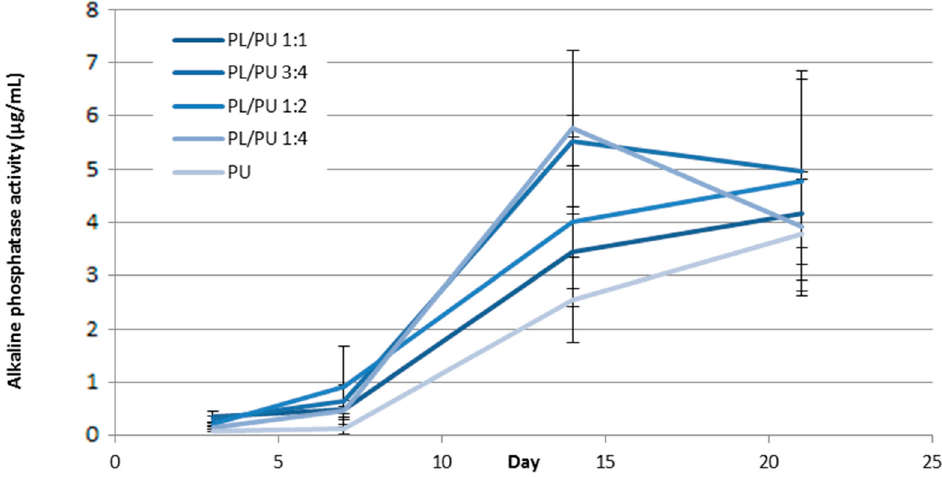
Figure 6. Alkaline phosphatase activity throughout a 21-day culture period expressed in 7F2 cells on polyurethane composites ( n = 5).